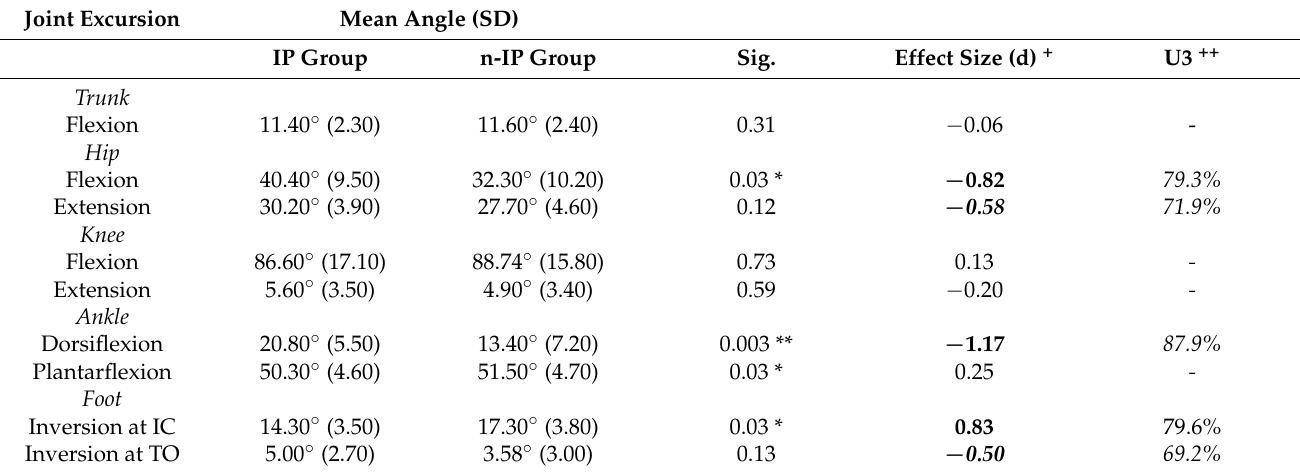
Table 3. Kinematic parameters of recreational